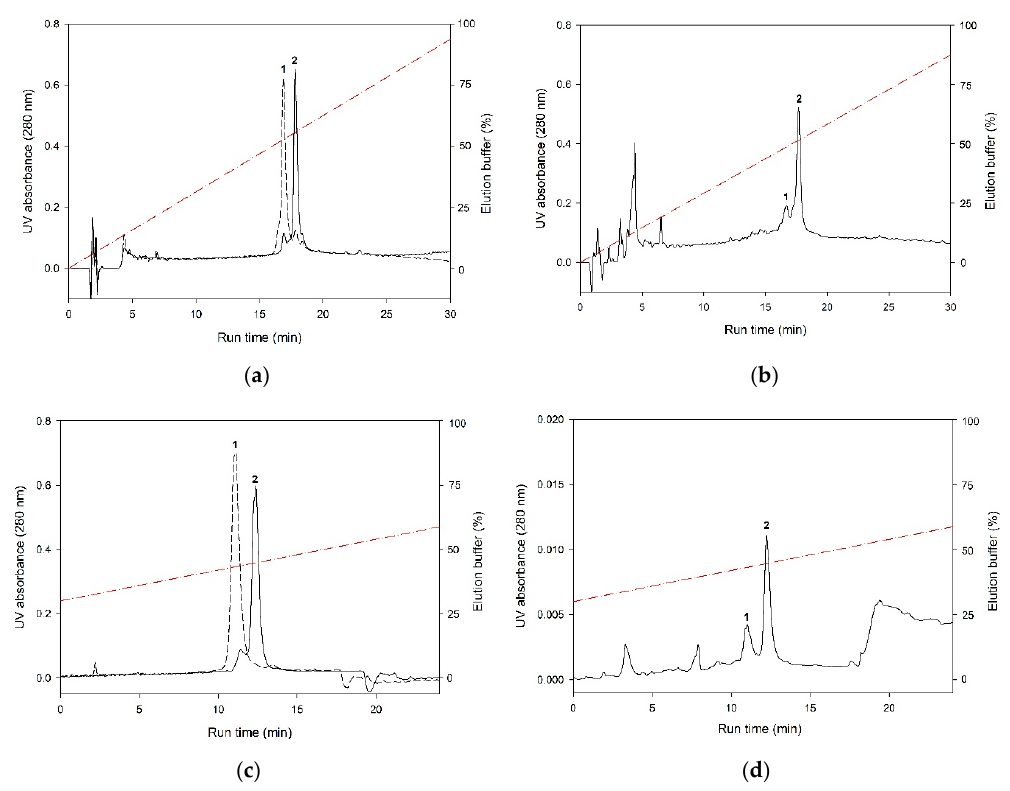
Figure 2. Distribution of recombinant recoverin and NCS-1 between soluble and insoluble fractions